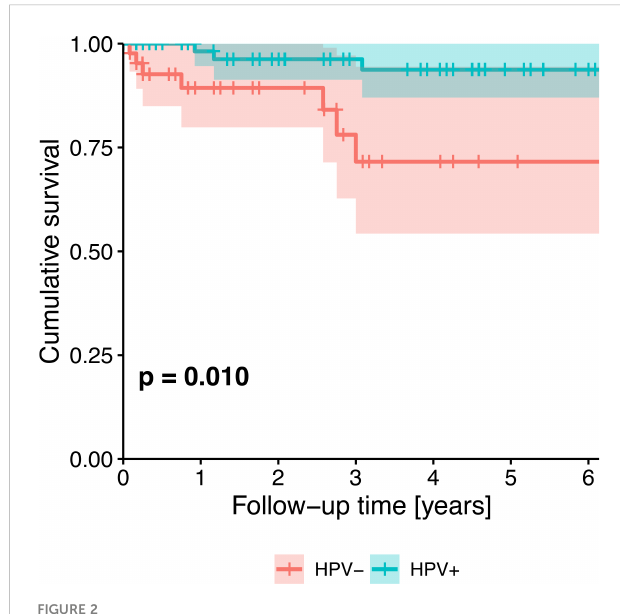
FIGURE 2 Kaplan-Meier survival plot showing the univariate effect of HPV status (HPV-negative patients vs. HPV-positive patients) on survival of all patients. P-value from likelihood ratio test against the null